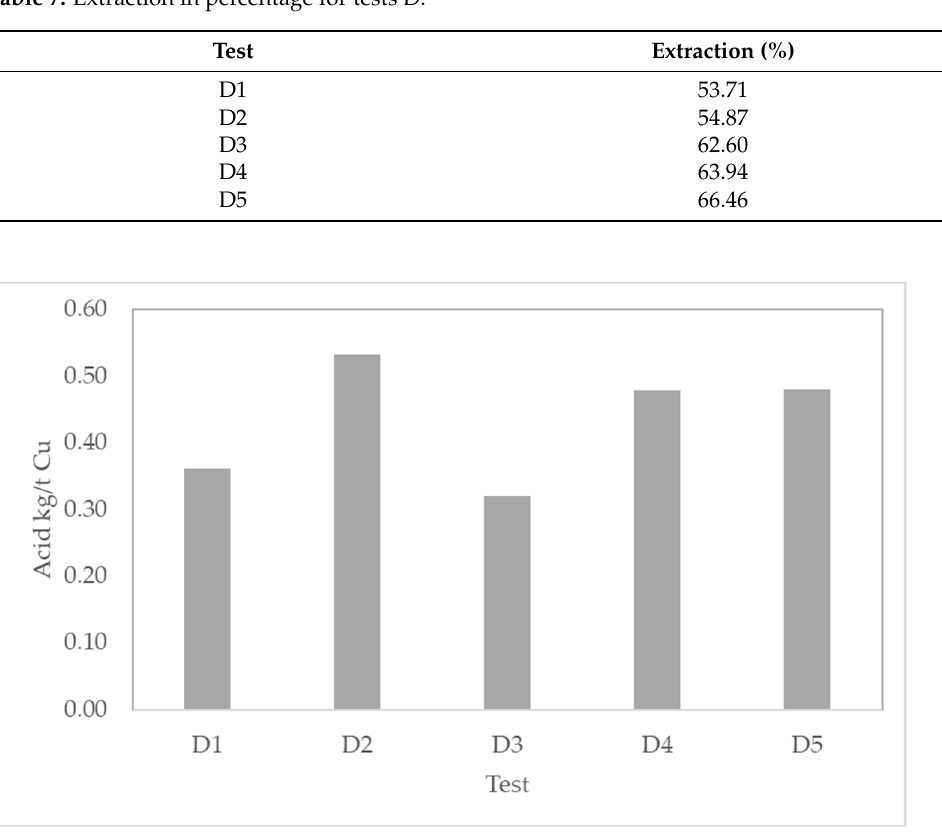
Figure 7. Total acid consumption in kg/t Cu for all columns in tests D.